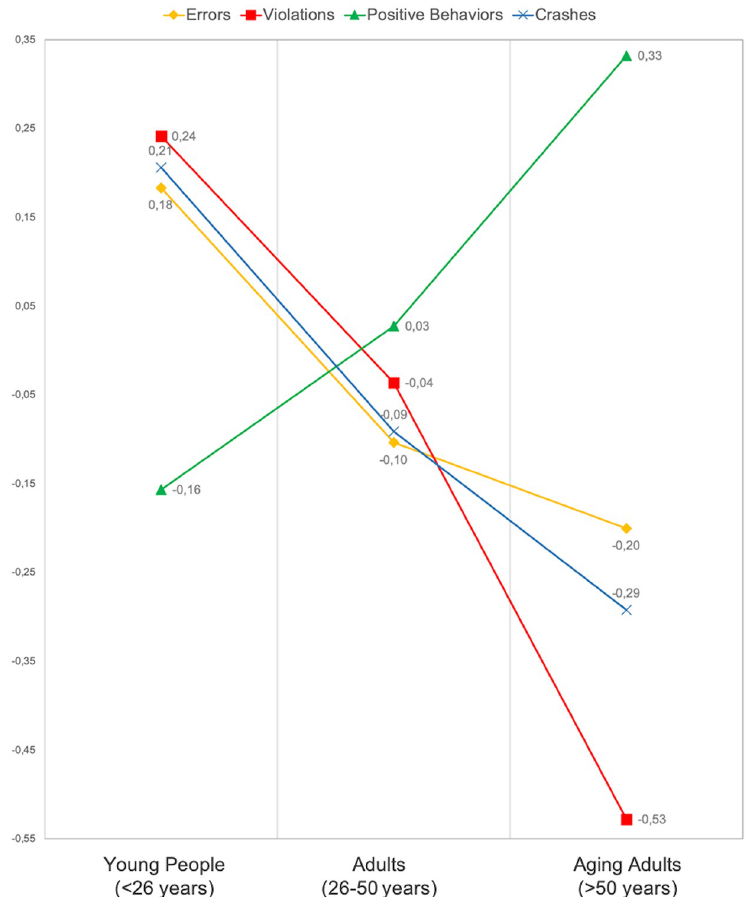
Fig 1. Graphical trends in risky behaviors -errors and traffic violations-, positive behaviors and traffic crash rates among cyclists in different age groups (standardized values).